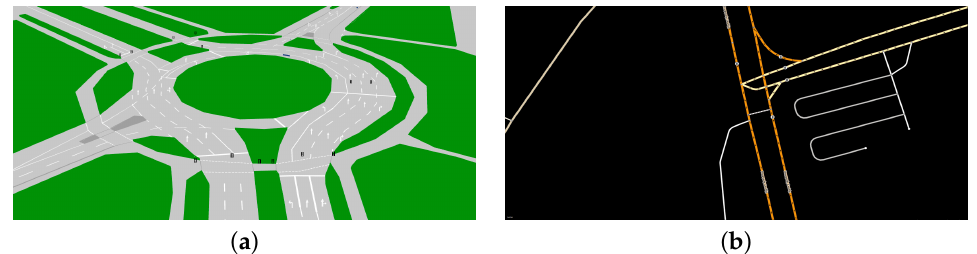
Figure 4. ( a ) Sample HD map used for autonomous driving with detailed representation of every traffic mark (Poggenhans et al. 2018). ( b ) Sample map from OpenStreetMap, providing rough information on the road